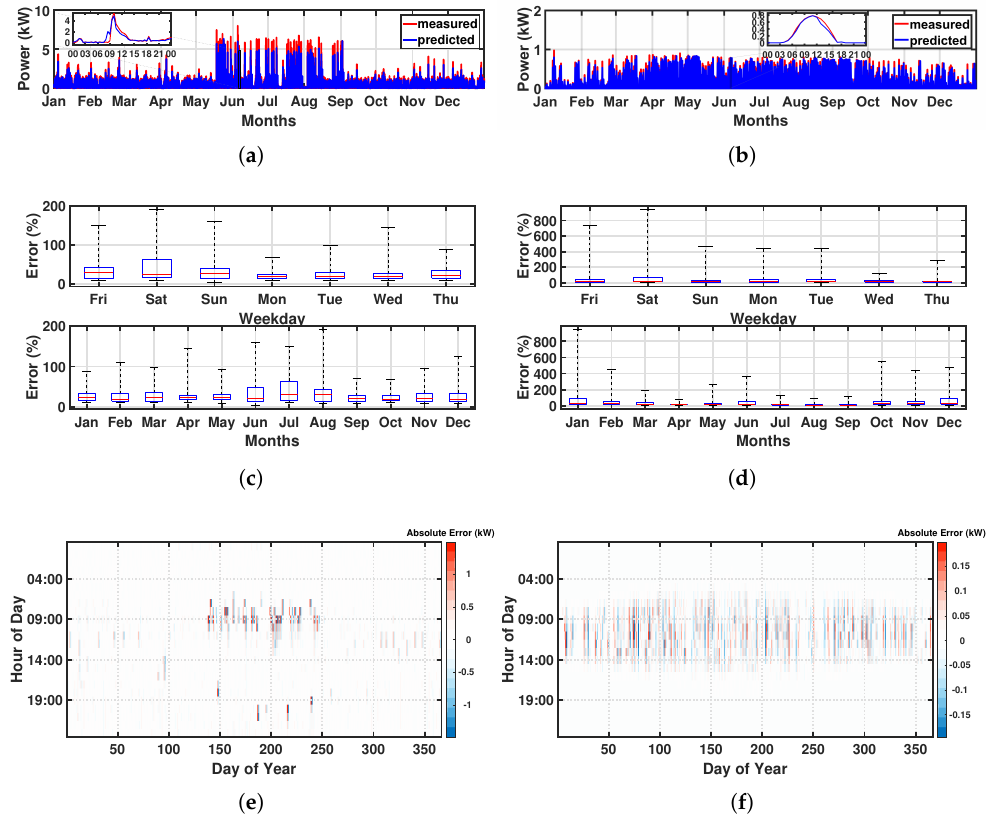
Figure A3. ( a ) Measured and predicted values of electrical power consumption of a household, ( b ) PV power production, ( c ) relative prediction error distribution statistics of residential power consumption, and ( d ) pv power production, ( e ) corresponding absolute error values over one year for power consumption, and ( f ) PV power production [43].